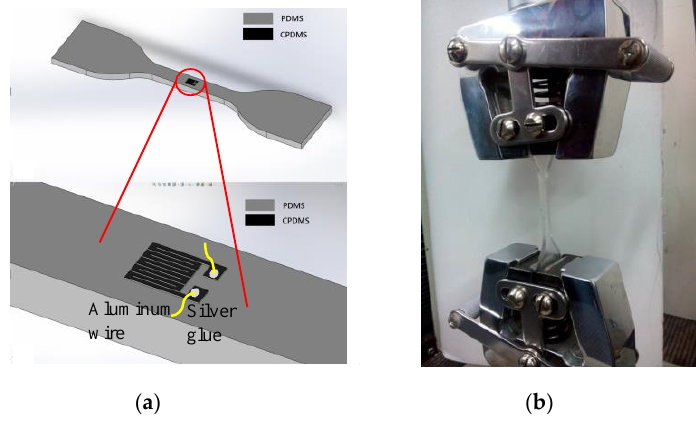
Figure 6. Piezoresistance measurement of ( a ) CPDMS attached on a strain gauge with ( b ) universal testing machine.